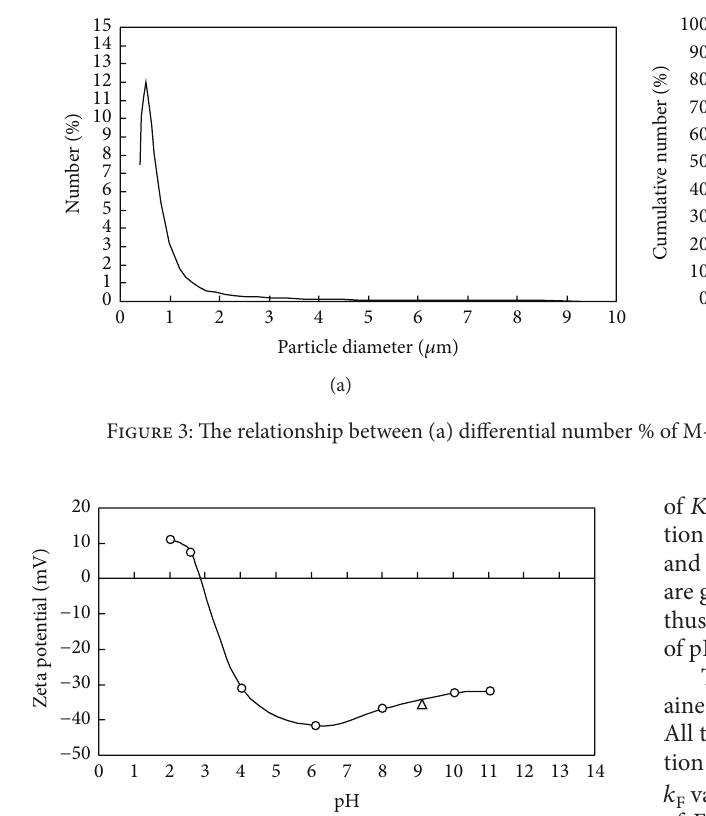
0 of 5, 6.04–6.64, and 7, 0 = 5, 6.04–6.64, and 7, respectively.